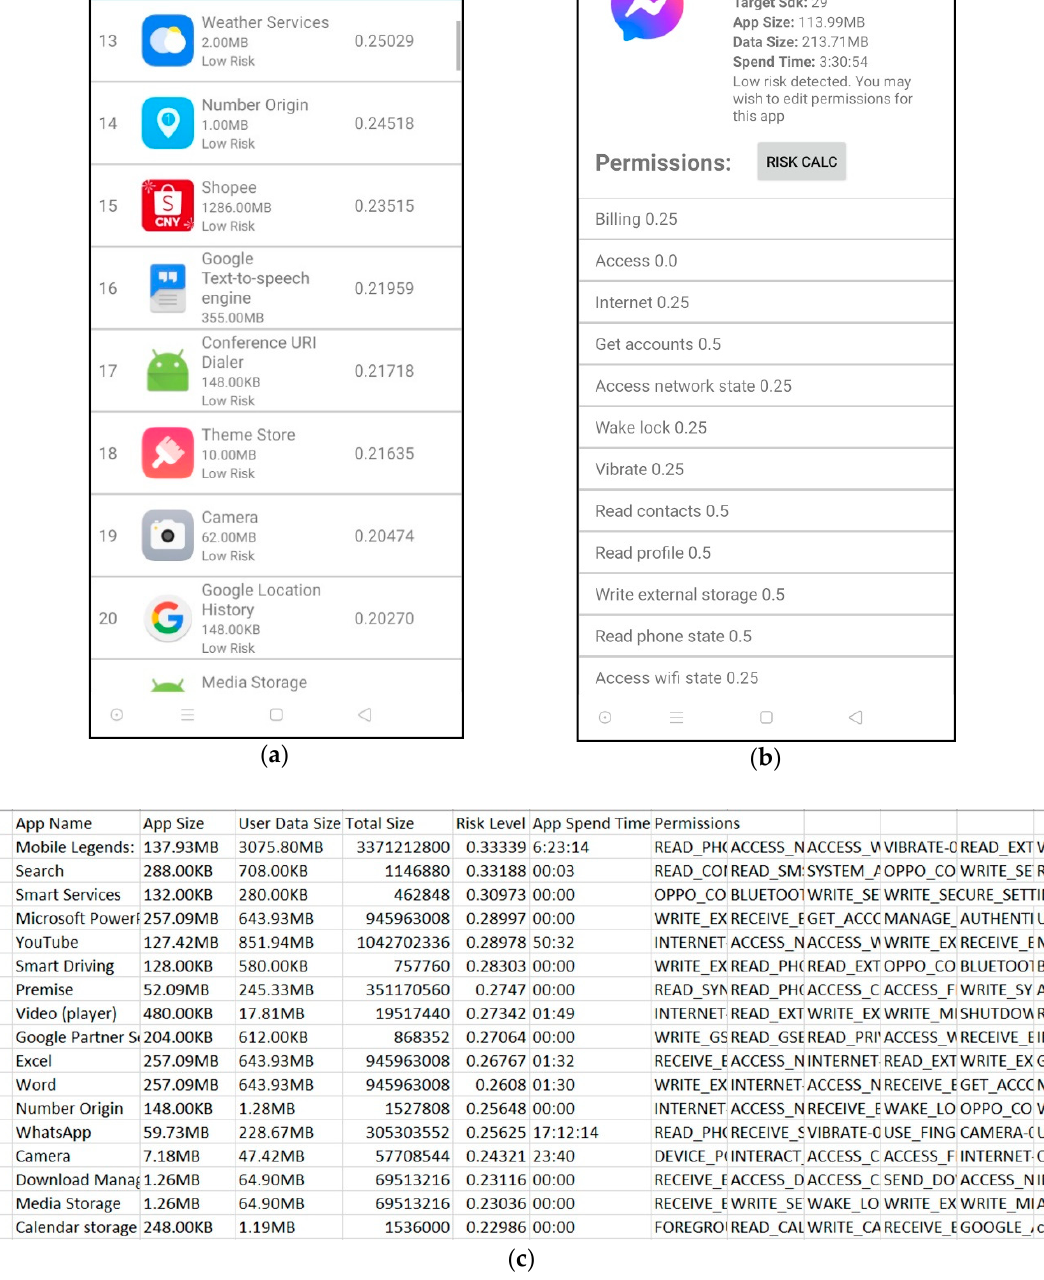
Figure 4. ( a ) Interface of AMoDaC listing all installed applications and their risk values; ( b ) Interface of AMoDaC showing additional information on the specific applications; ( c ) Usage report generated by the user via AMoDaC tool. A range for application risk is assigned based on the assignation of values for each permission level in Section 3.1. The risk range posed by each application is shown in Table 6.